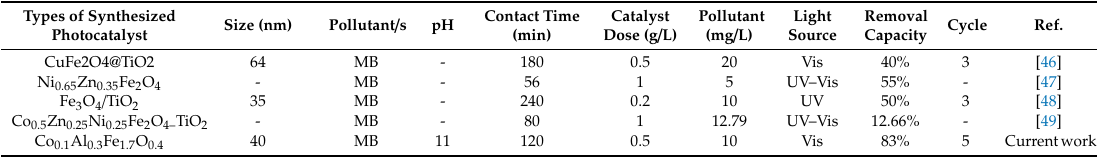
Table 3. A comparison of different modified spinel ferrite with Co 0.1 Al 0.3 Fe 1.7 O 0.4. Types of Synthesized Photocatalyst